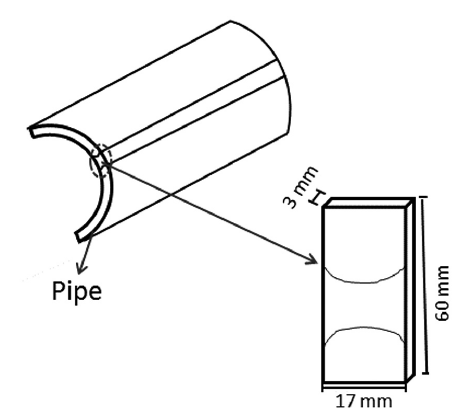
Figure 1. Specimen dimensions in mm.